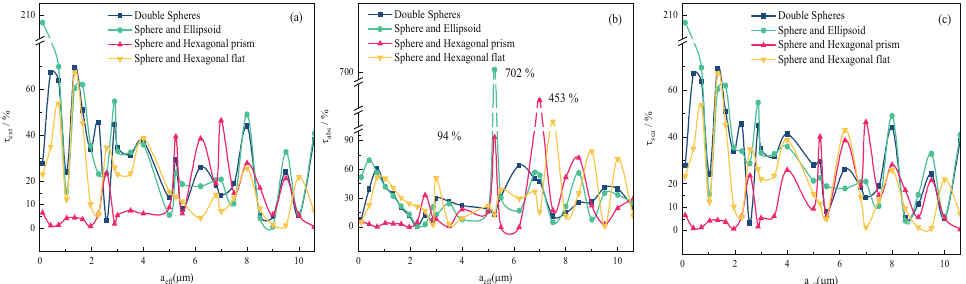
Figure 8. The relative errors of extinction efficiency, absorption efficiency, and scattering efficiency of (cid:1) ice crystal particles at Θ = 0 ◦ and Θ = 90 ◦ spatial position. ( a ) relative error of extinction efficiency; ( b ) relative error of absorption efficiency; ( c ) relative error of scattering efficiency.